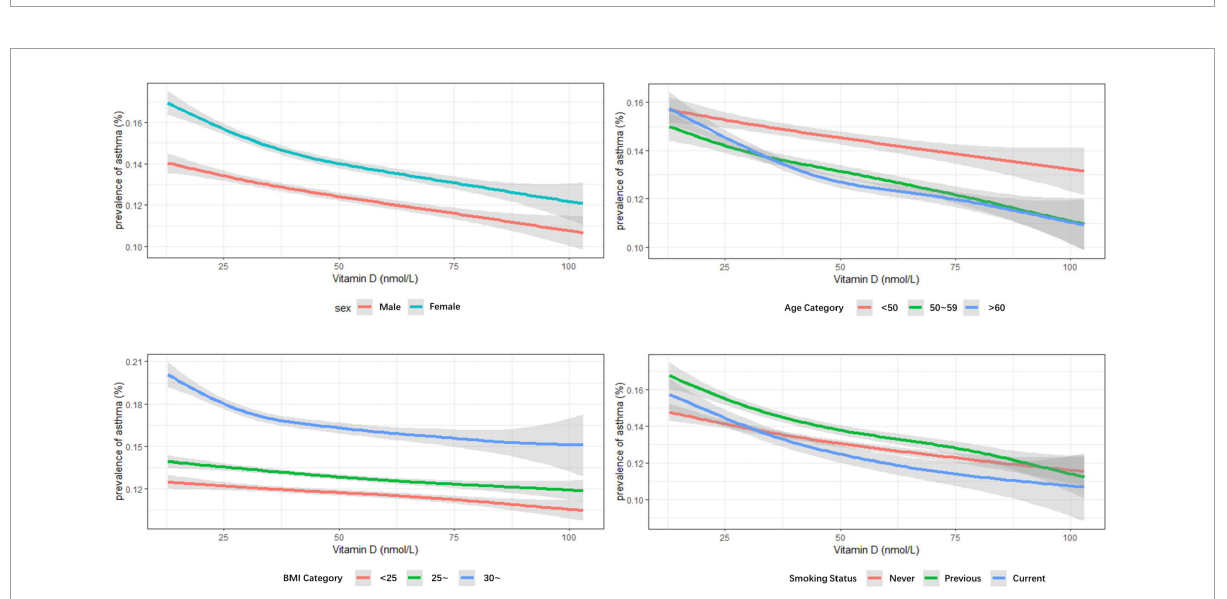
FIGURE2 Prevalence of asthma by serum levels of vitamin D.